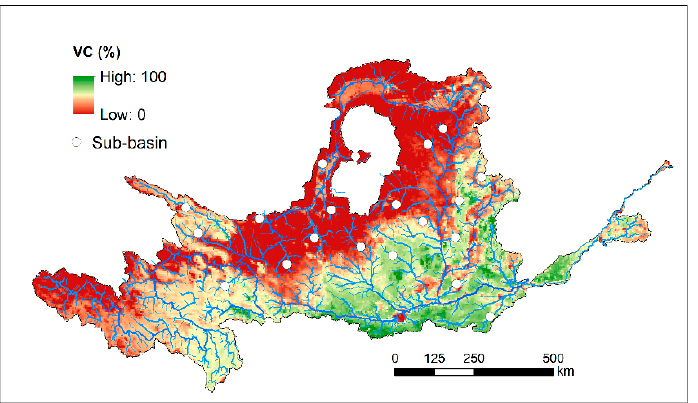
Figure A2. Vegetation coverage and distribution of 20 representative sub-basins in the Yellow River basin.